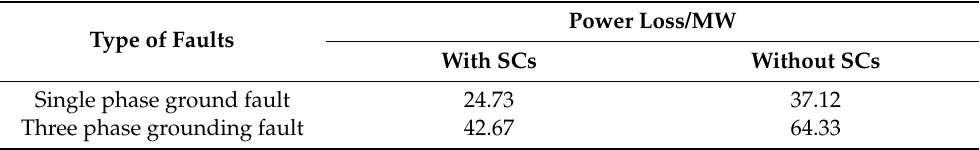
Table 4. Comparative chart of electrical